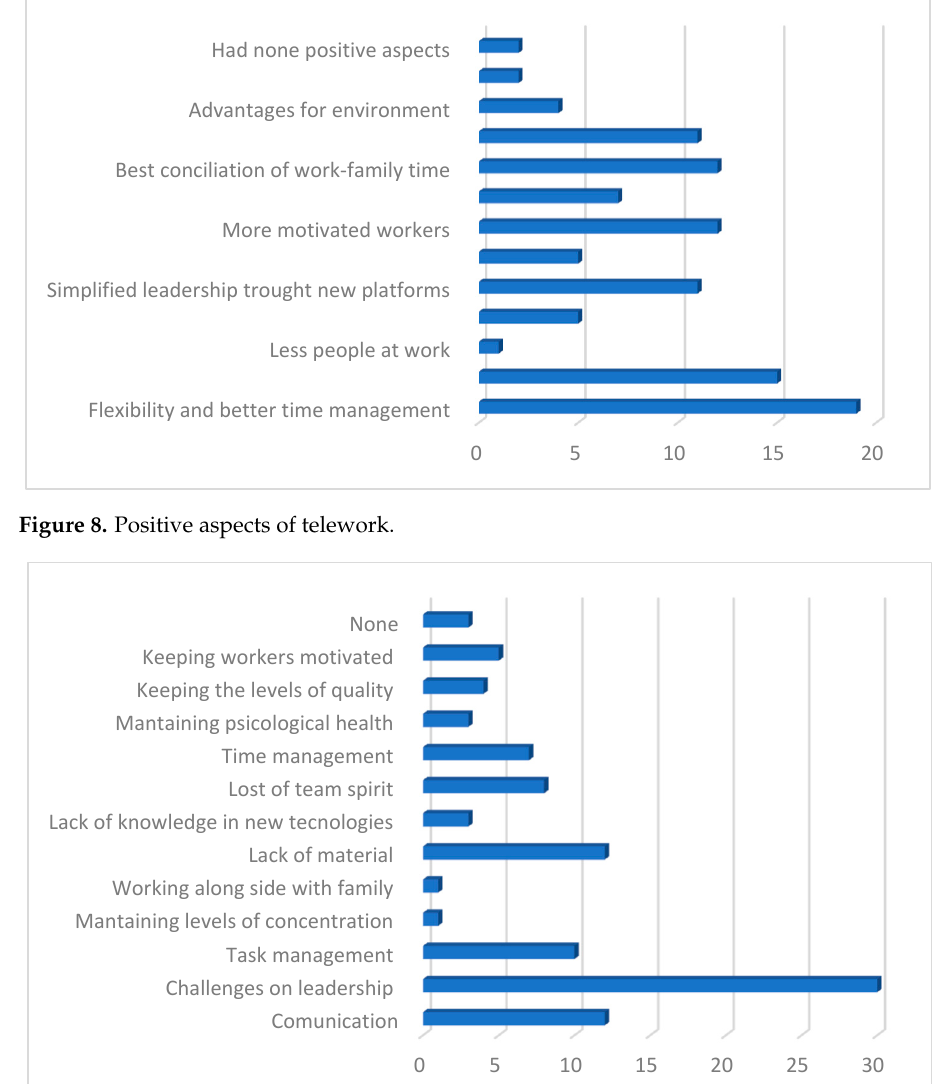
Figure 10. Solutions to minimize the negative impacts of telework. Figure 9. Negative aspects of telework.